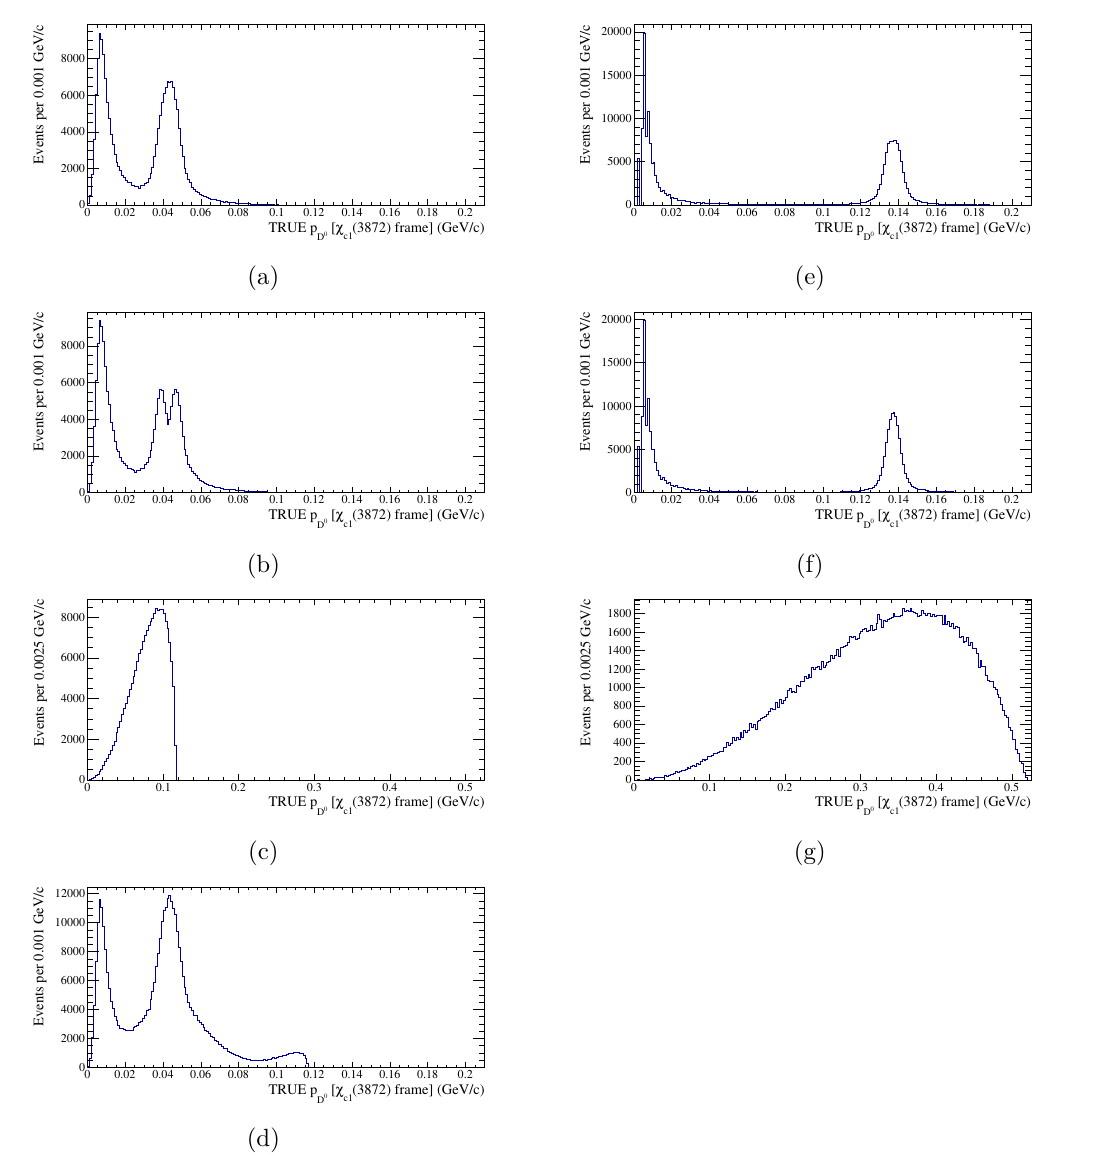
Figure 5. TRUE p in the χ c 1 (3872) rest frame for prompt (a) χ c 1 (3872) → D 0 D 0 π 0 D 0